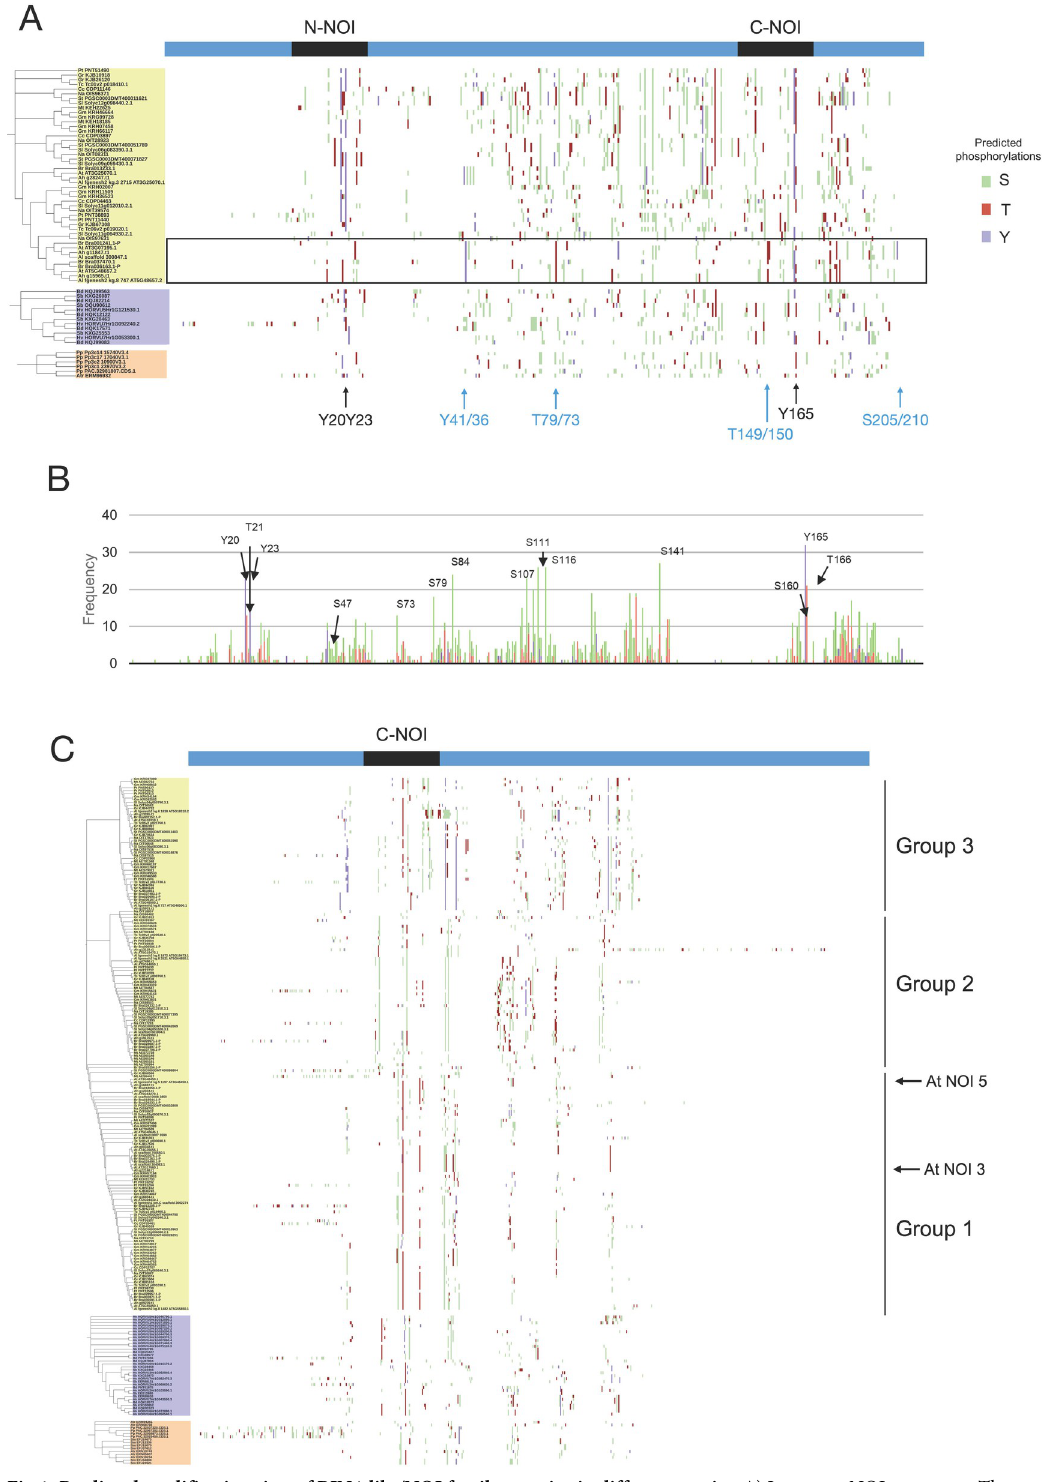
Fig 4. Predicted modification sites of RIN4-like/NOI family proteins in different species. A) Long two-NOI sequences. The group of sequences containing NOI10 and NOI11 is marked with a rectangle. The locations of relevant conserved modifications in this group are shown in blue. B) Recurrence of the predicted modifications per site in long two-NOI dicot sequences, determined as the number of sequences that contains a specific modification. B) Short one-NOI sequences. In A) and B), dicot labels are shown